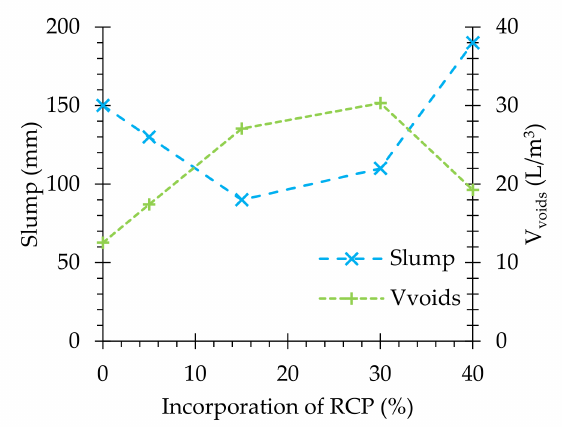
Figure 6. Slump and volume of voids, V voids , as a function of the incorporation percentage of RCP in concrete with a w/b of